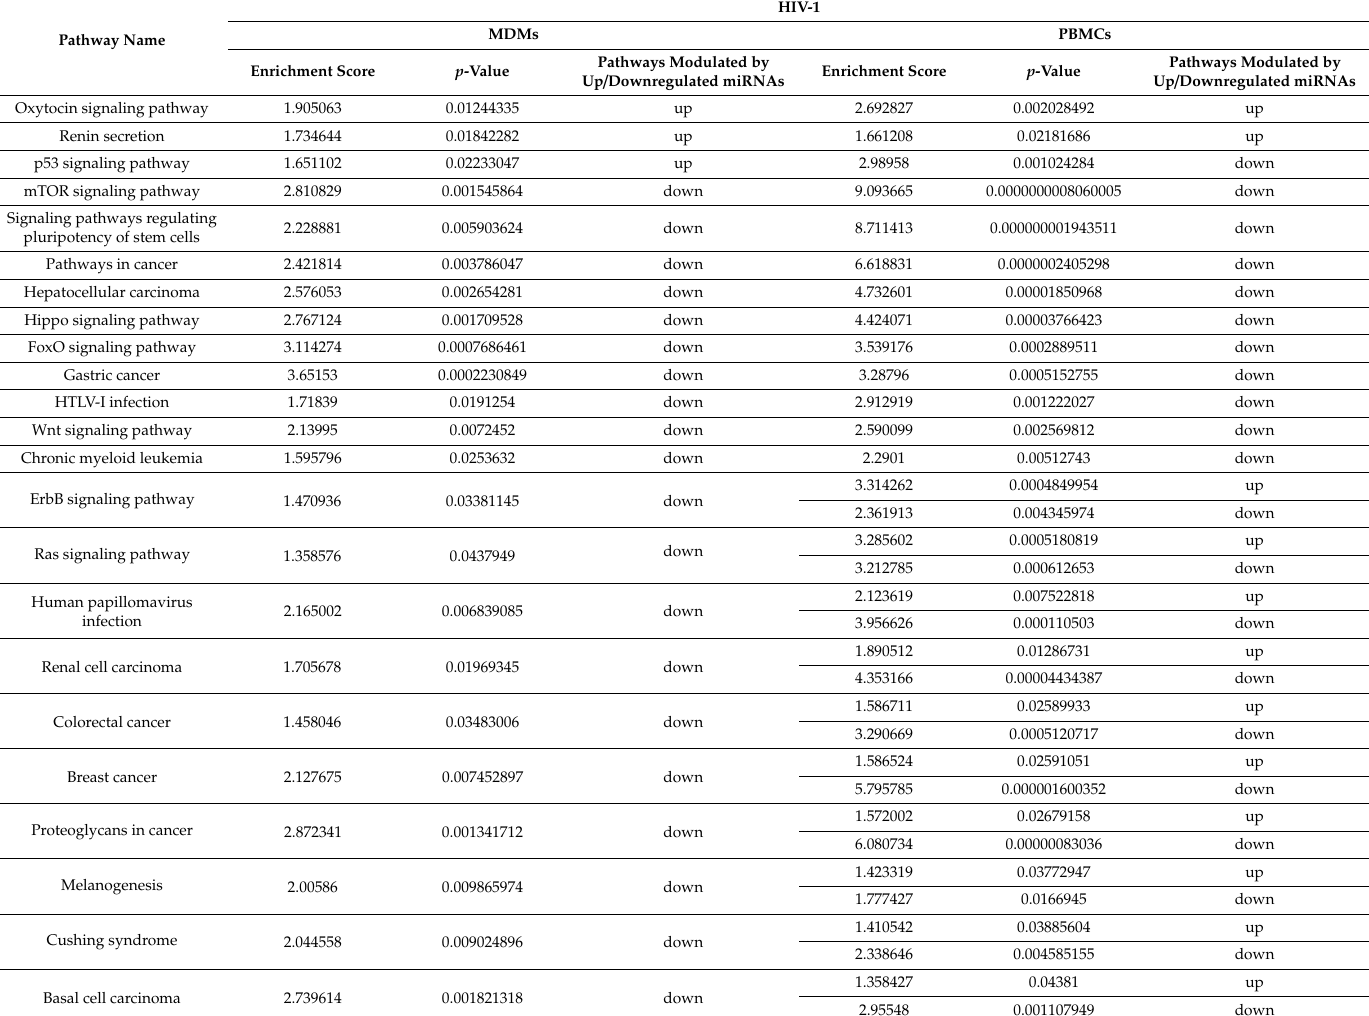
Table 4. Common pathways modulated by di ff erentially expressed miRNAs in HIV-1-infected MDMs and